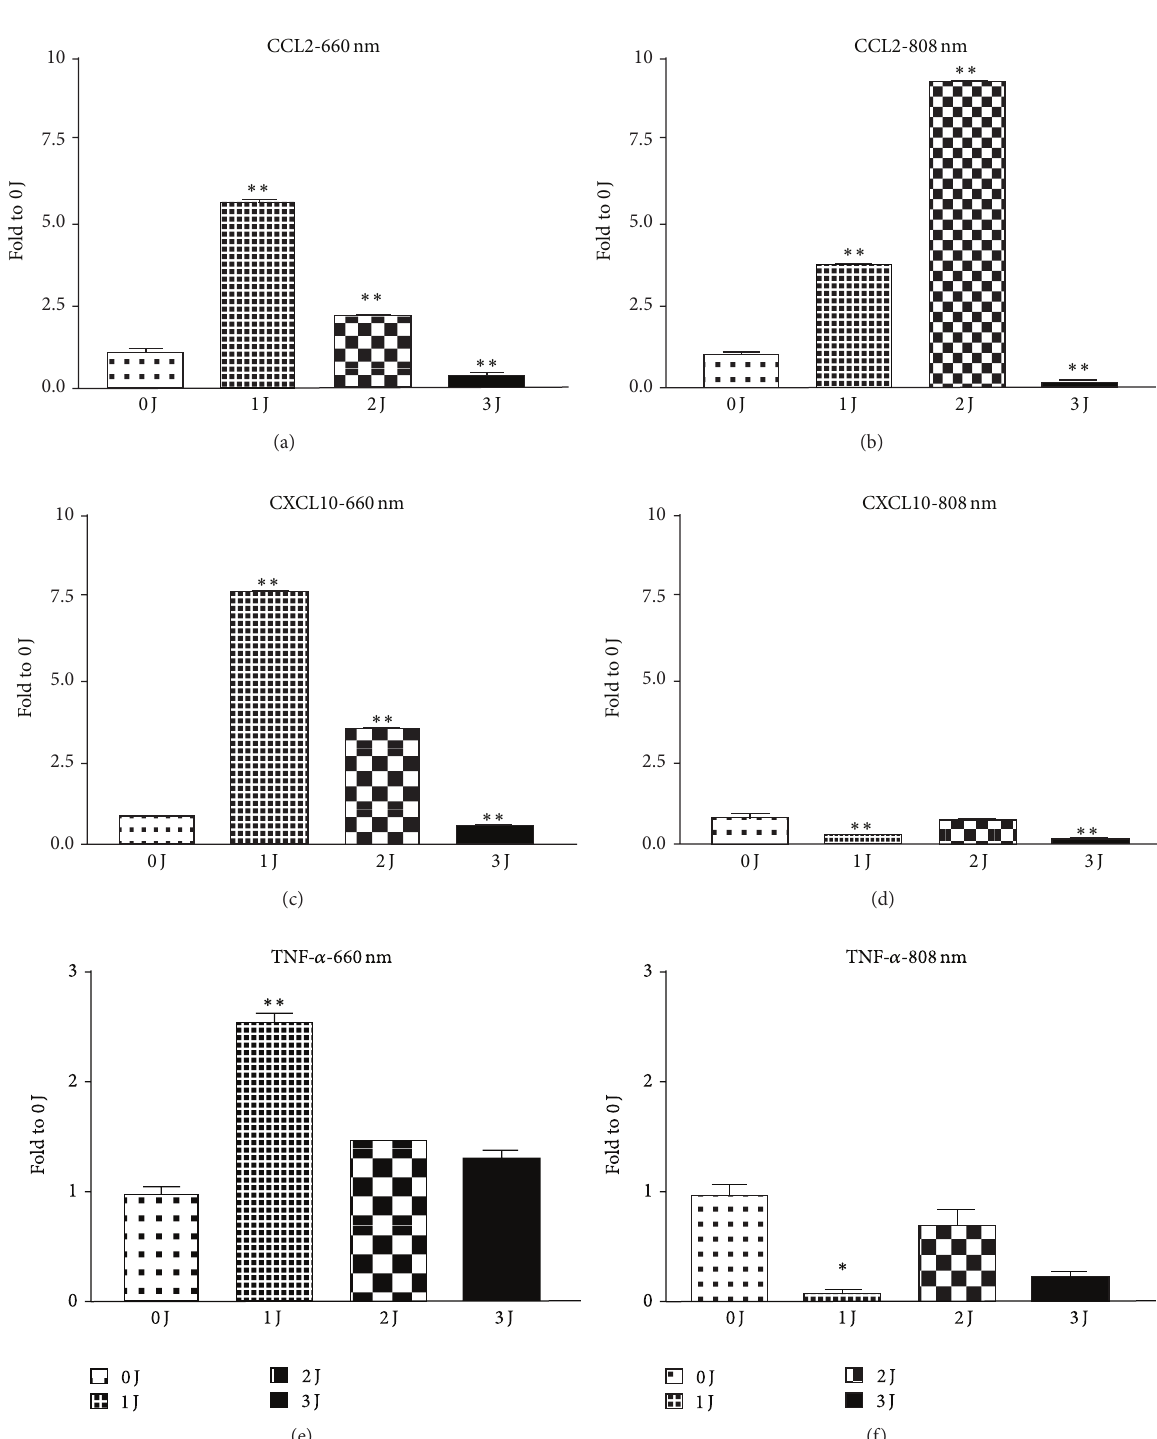
Figure 1: Effect of LLLT on M1-related chemokine and cytokine mRNA expression in THP-1 cells using real-time PCR analysis. M1-related chemokines CCL2 and CXCL10 expression was enhanced by 660 nm (1-2J/cm 2 ) and 808 nm (2J/cm 2 ) LLLT ((a) and (b)). However, 3J/cm 2 of LLLT (660 and 808 nm) suppressed CCL-2 expression in THP-1 cells. CXCL-10 mRNA expression was enhanced by 660 nm LLLT but was suppressed by 808 nm LLLT ((c) and (d)). TNF- 𝛼 was also enhanced by 660 nm LLLT but was suppressed by 808 nm LLLT 24 hours after irradiation ((e) and (f)). ∗ 𝑃 < 0.05 ; ∗∗ 𝑃 < 0.01 ; and ∗∗∗ 𝑃 < 0.001 between control and LLLT